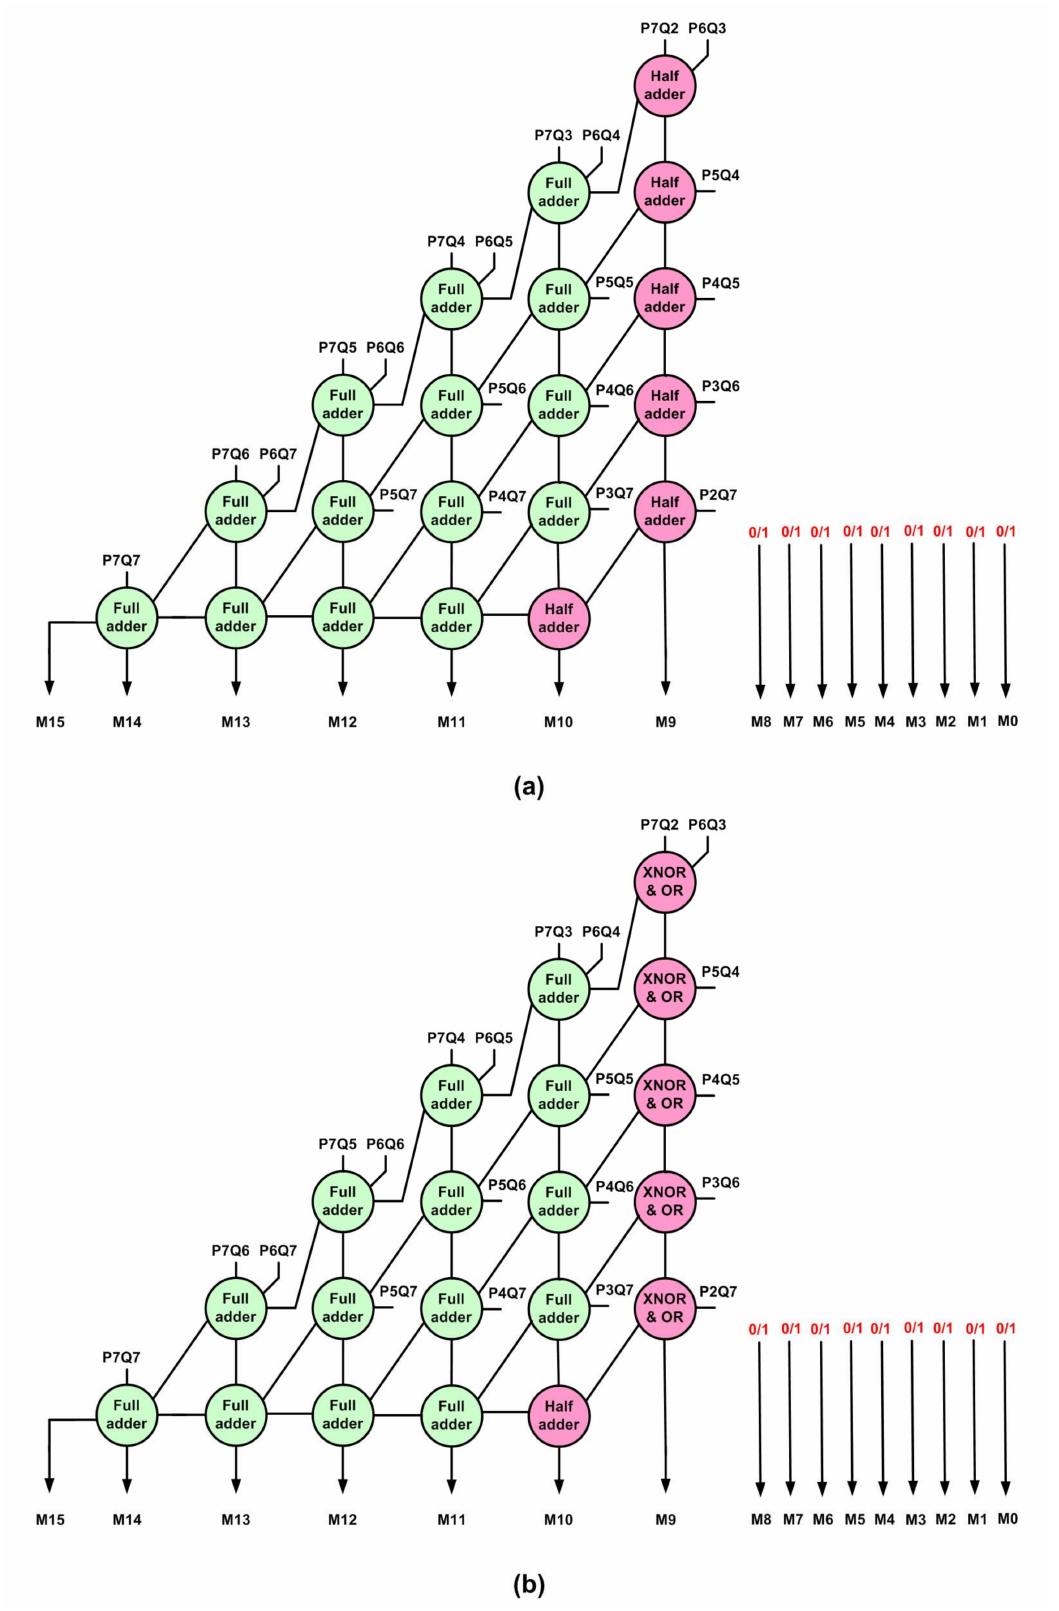
Figure 3. ( a ) Logic schematic of IAM00 and IAM01 architectures resulting from vertical cut VC8 made on the 8 × 8 EAM. ( b ) Logic schematic of IAM10 and IAM11 architectures resulting from vertical cut VC8 made on the 8 × 8